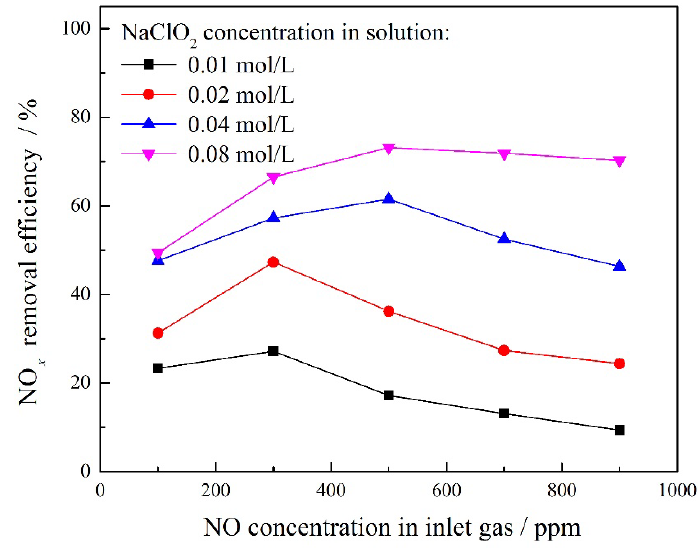
Figure 9. The change of the NO x removal efficiency with the NO concentration of the inlet gas.